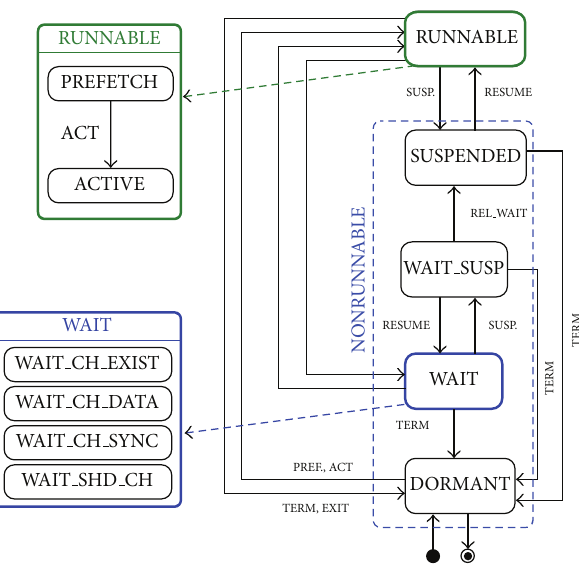
Figure 12: HWT State (HWT Management and Communication Layer